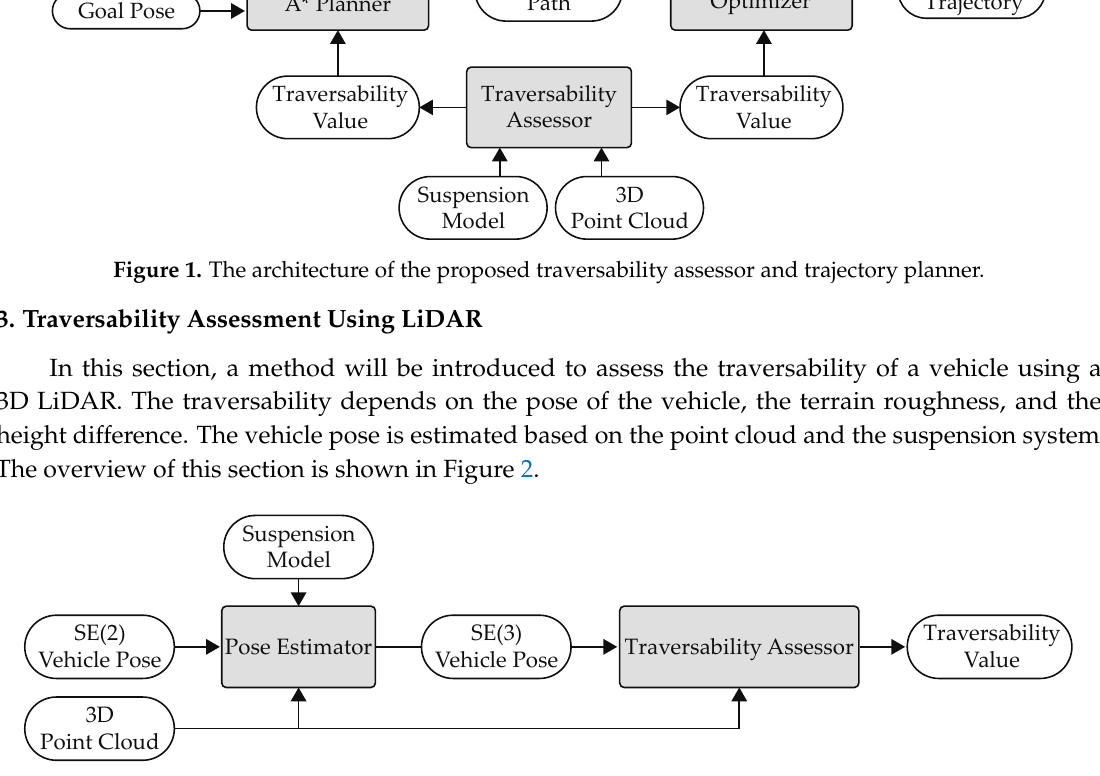
Figure 2. The overview of the traversability assessment approach.